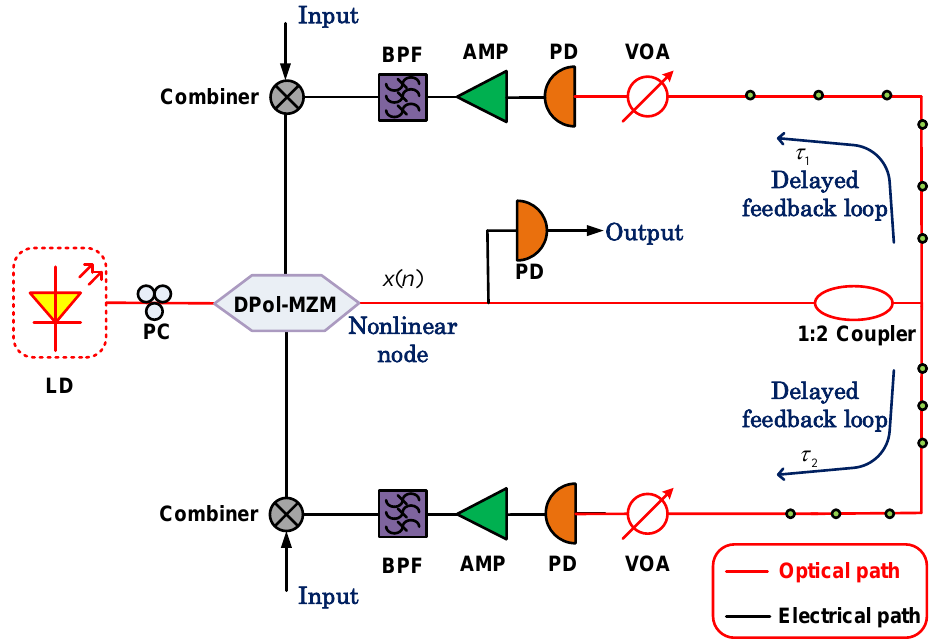
Figure 2. DPol-MZM-based double-loop reservoir structure diagram. LD: laser diode; PC: polariza- tion controller; DPol-MZM: dual-polarization Mach – Zehnder modulator; OA: optical attenuator; PD: photodetector; AMP: amplifier; BPF: bandpass filter.